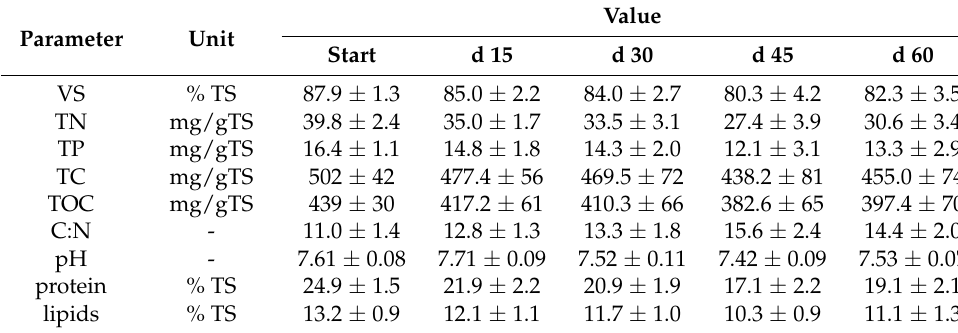
Table 3. Profiles of the evolving M-BGS biomass across H-PBR operation phases.